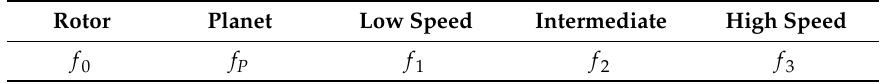
Table 2. Nomenclature and numbers of teeth for each gear.